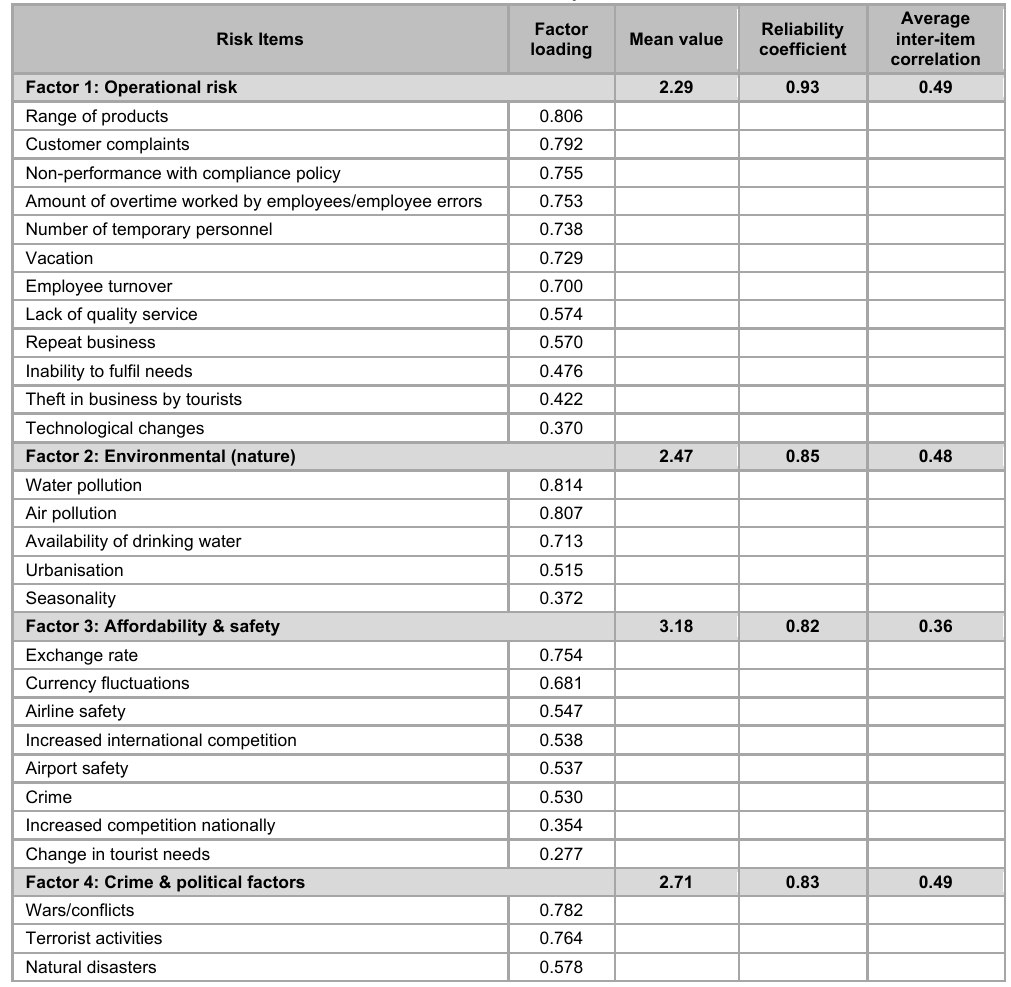
Summarised factor analysis